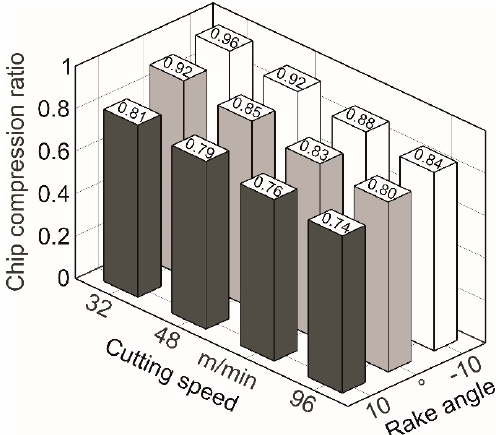
Figure 5. Plot of chip compression ratio for different rake angles and cutting speeds in the machining of AISI 1045 steel.